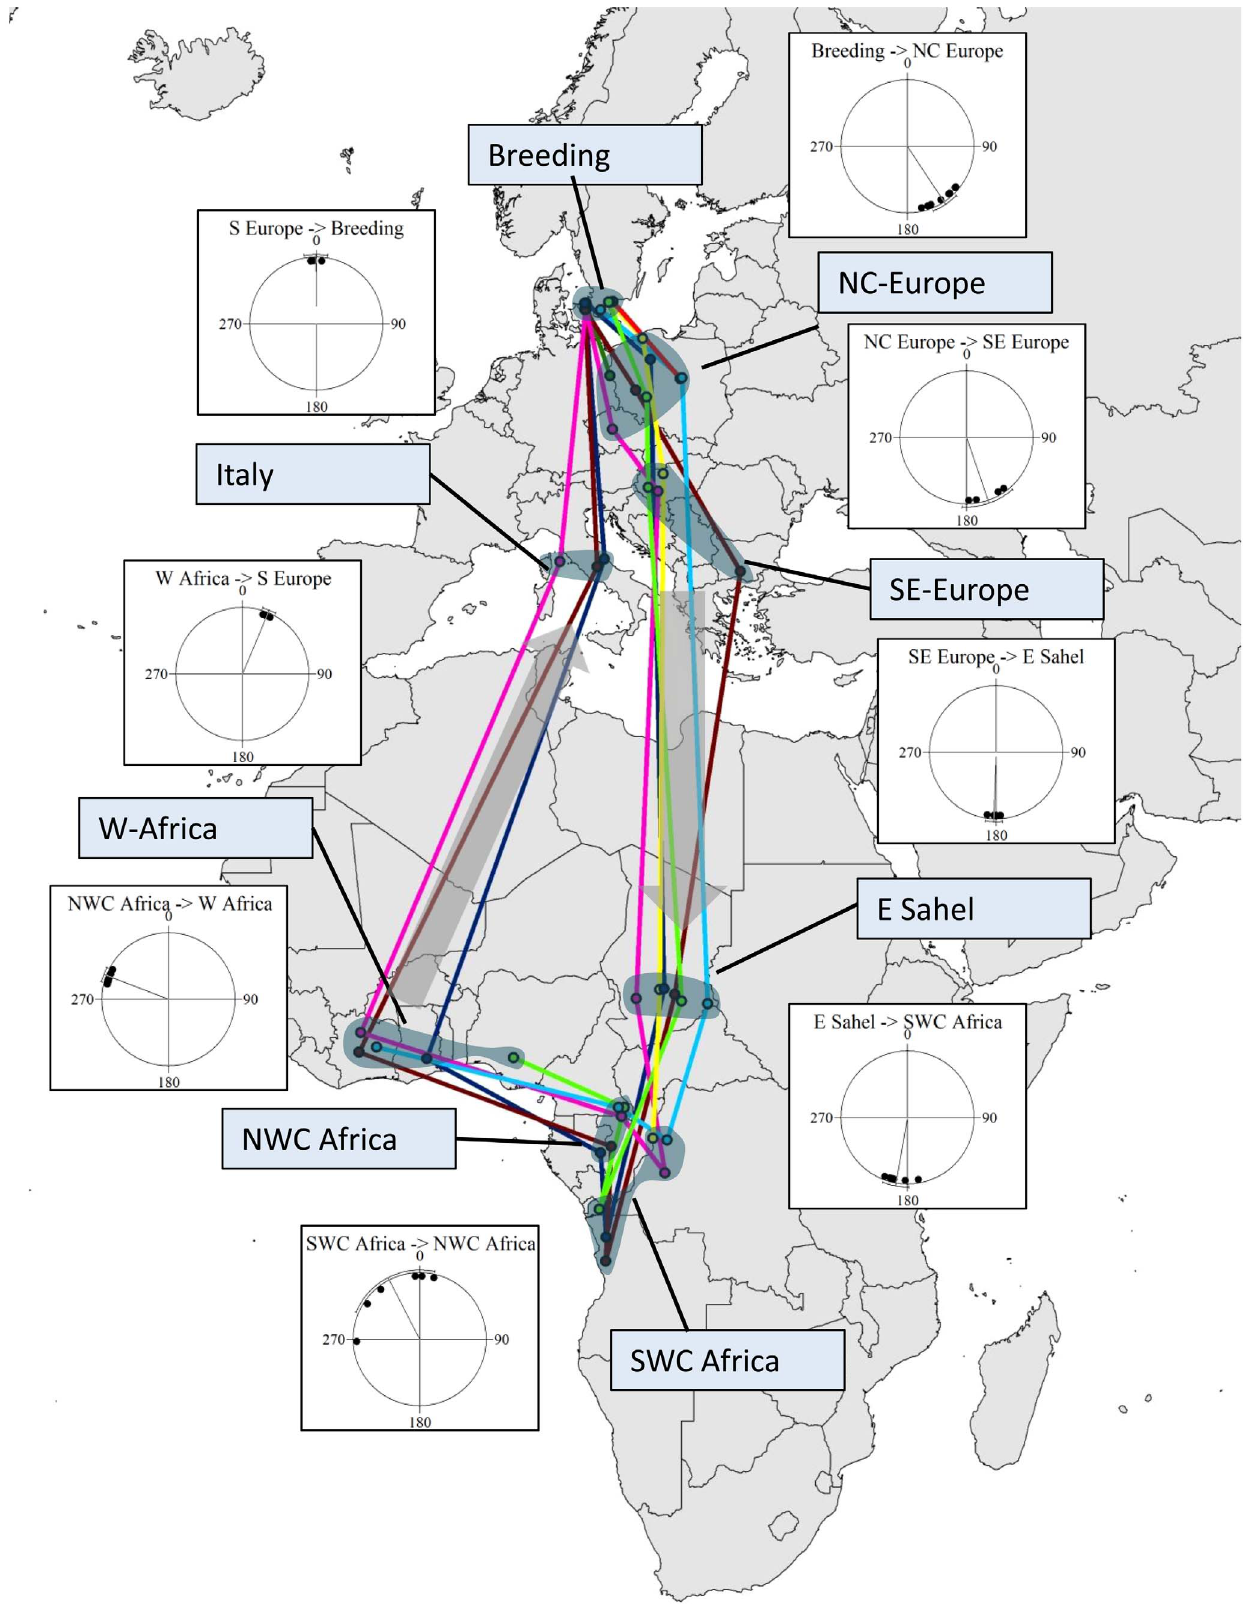
Figure 1. Staging areas of eight satellite-tracked adult common cuckoos with vector directions between stopovers indicated by inserted orientation diagrams. Lines are connecting staging sites and do not necessarily represent the paths followed (see ESM Fig. S1). Mercator projection. doi:10.1371/journal.pone.0083515.g001 PLOS ONE | www.plosone.org 5 January 2014 | Volume 9 | Issue 1 |